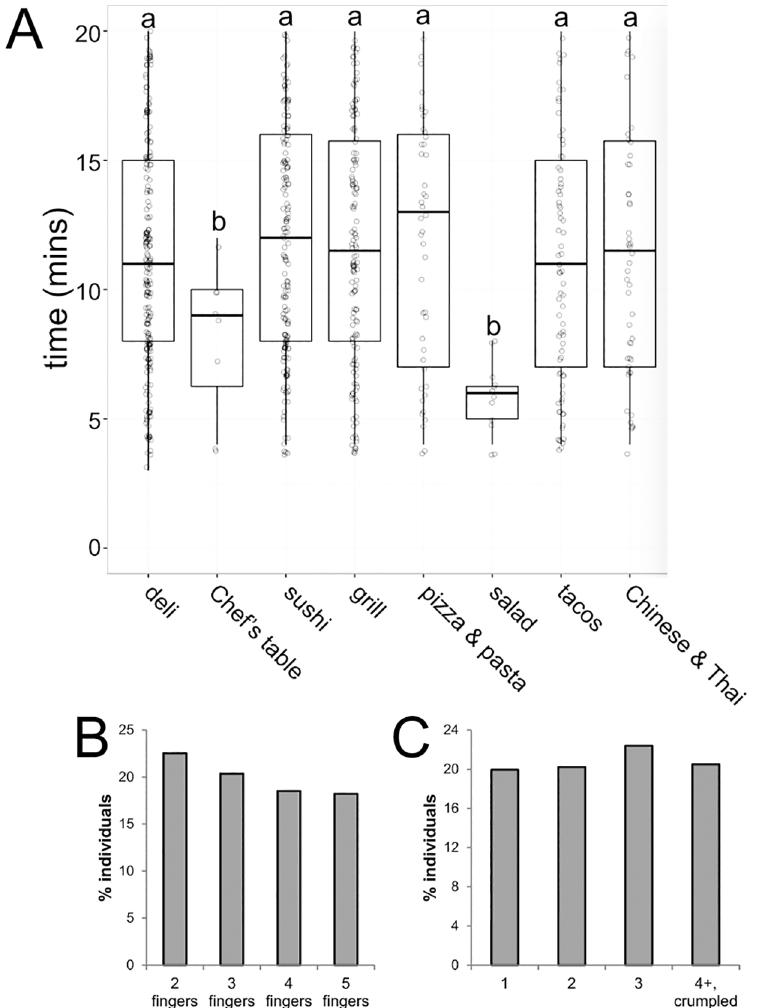
Fig 1. Characteristics of thermal paper handling by study participants. A) In most of the diningstations, individuals handledthermal paper for 10–12minutes. Two stations were associated with decreased handling times, the salad station and Chef’s Table. Both of these stations involvepreparingfood prior to the acceptance of the receipt. Groups with different superscripts (letters a, b) indicatesignificantdifferences, p < 0.05,Bonferroni adjustedposthoc comparisons after significant1-way ANOVA. B) Characteristics of the numberof fingers individuals used to handlethermal receipts. C) Characteristics of the number of folds participants made when handlingthermal